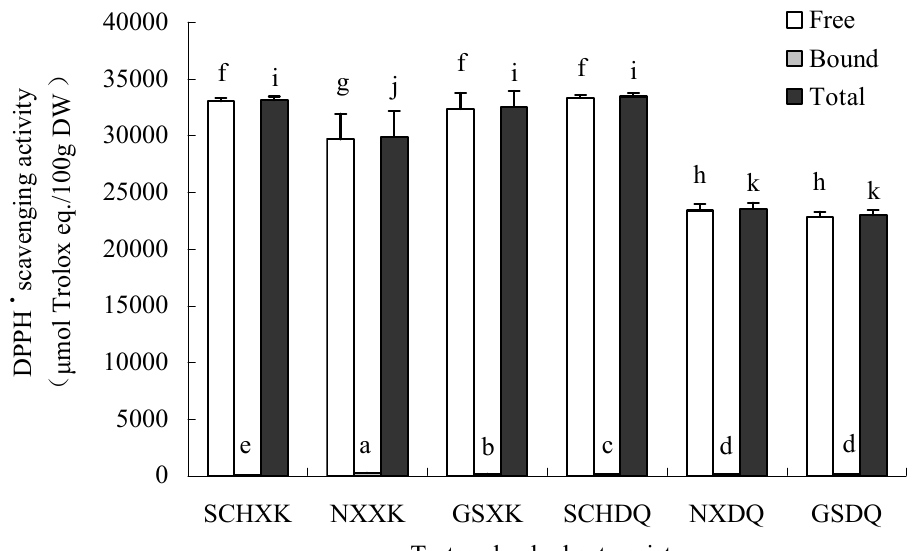
Figure 1. DPPH radical scavenging activity of two tartary buckwheat varieties grown at 3 locations ( μ mol Trolox eq /100 g DW). ）